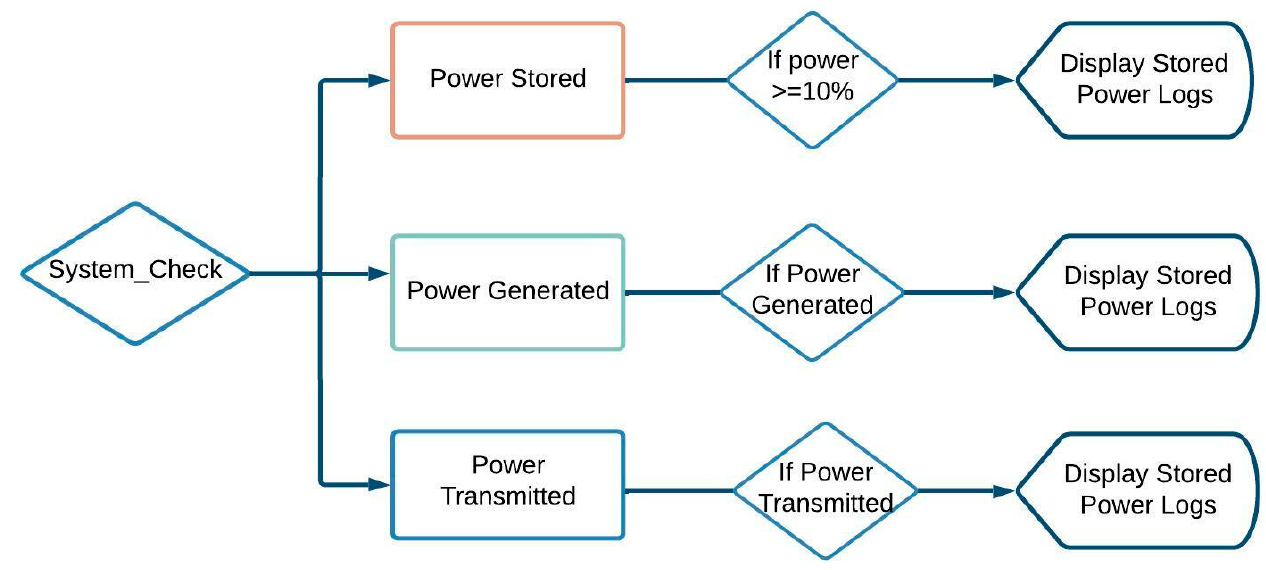
Figure 4. System Processes to Check Generated Energy.